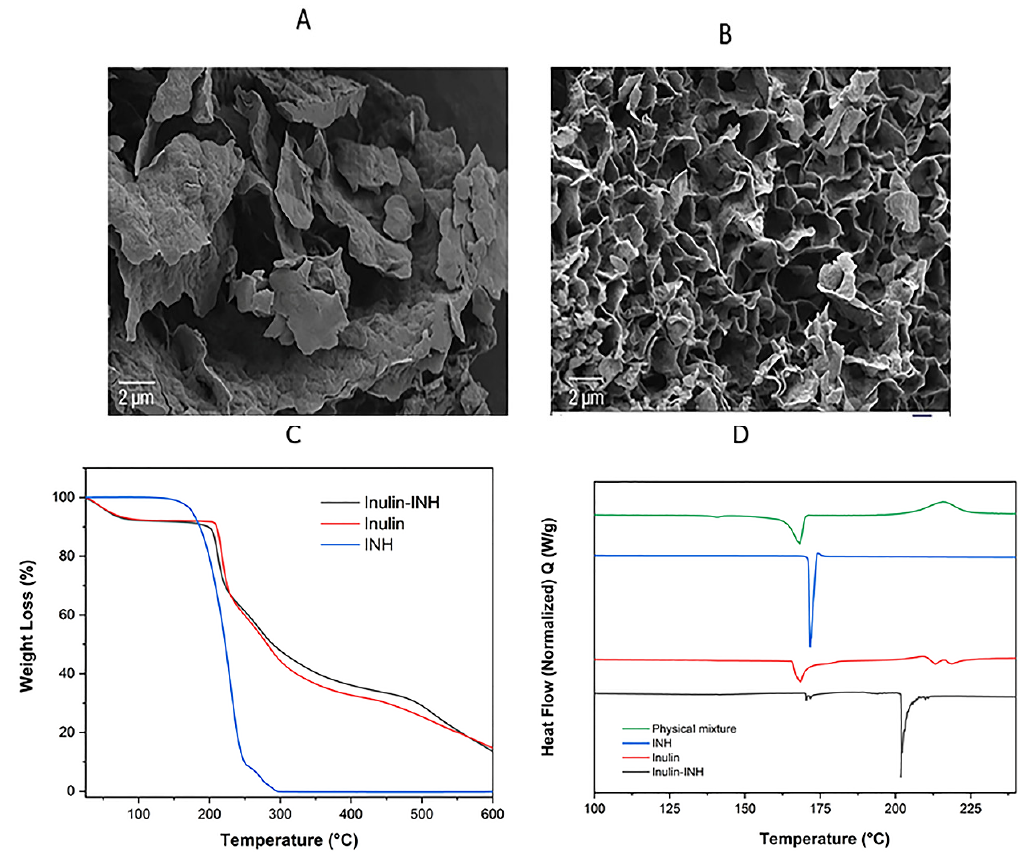
Figure 4. Scannng electron microscopy (SEM) micrograph of inulin microparticles ( A ) and inulin-INH ( B ). Magnification was 10,000× for both image A and B, TGA thermogram of INH, inulin microparticles and conjugate ( C ) and differential scanning calorimetry (DSC) thermograms of the physical mixture of oxidized inulin and INH, pure INH alone, inulin microparticles and conjugate ( D ).